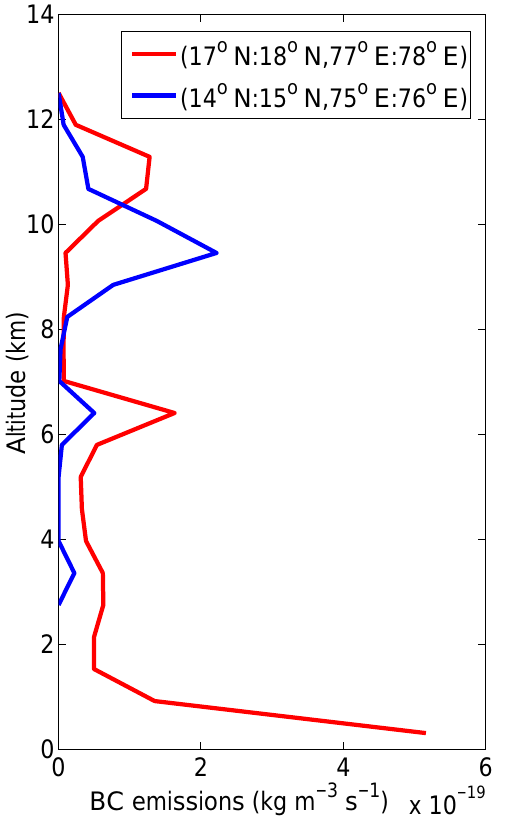
Figure 1. The vertical profile of BC emissions (kgm − 3 s − 1 ) from aircraft in the MACCity inventory over 1 ◦ × 1 ◦ grid boxes (a) cen- tred over Hyderabad (red line) (b) located 2 ◦ south-west of Hyder- abad (blue line) during the month of March